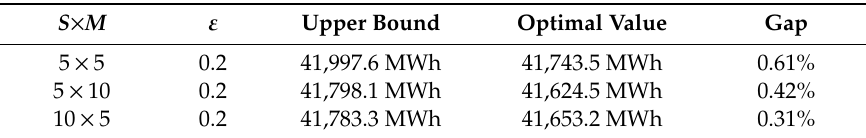
Table 9. Wind power utilization of di ff erent iteration numbers.